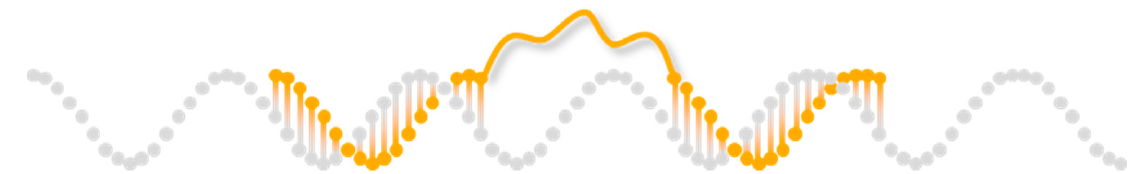
Figure 1. Schematic representation of the annealing of ASC1R (orange) to the target SARS ‐ CoV ‐ 2 RNA (gray).